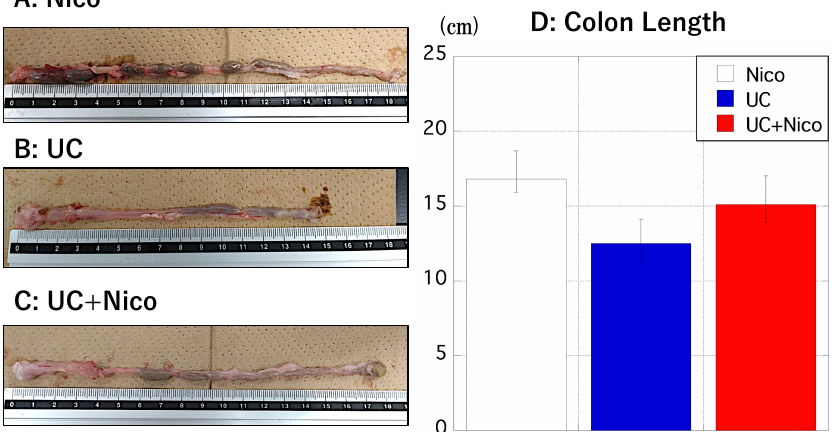
Figure 3. Changes in the colon length in the Nico, UC, and UC + Nico groups. ( A – C ) Longest colon tissue images from the Nico, UC and UC + Nico groups. ( D ) The y -axis indicates the colon length (in cm) of rats in Nico (white), UC (blue), and UC + Nico (red) groups after initiating the experiment. Data values are presented as the median ± max/min. Nico, nicotine; UC, ulcerative colitis.